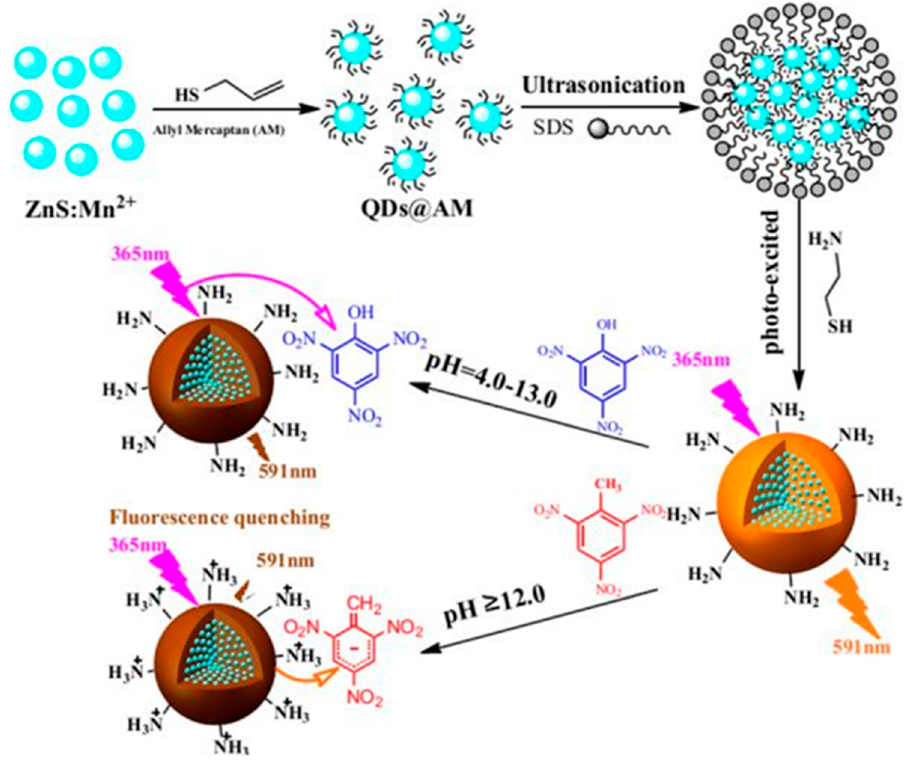
Figure 9. The fabrication of hydrophilic fluorescence nanocomposites (NCs) and the selective detection of TNT or TNP under optimal pH [68].